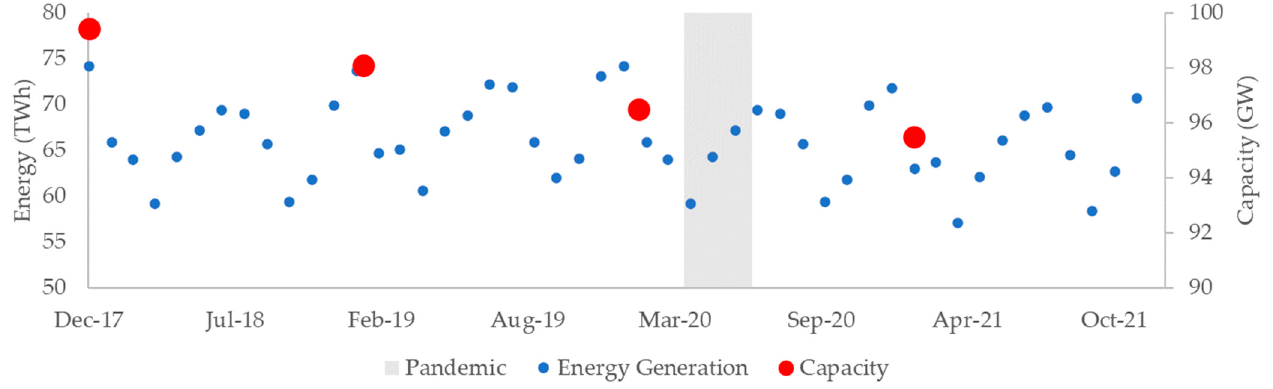
Figure 12. The 2019–2020 change (%) in renewable energy generation by state